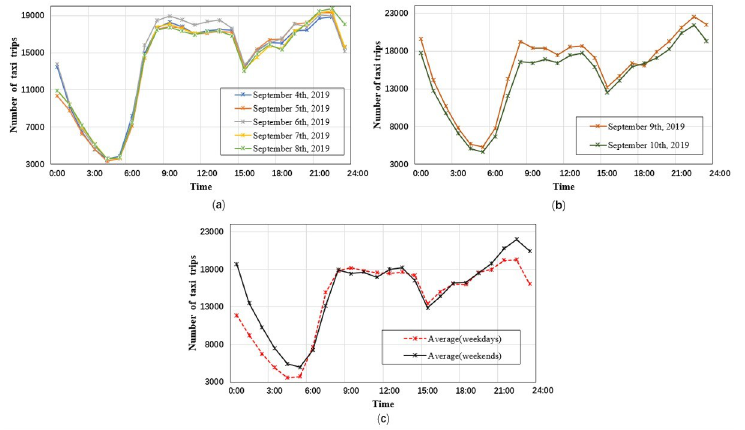
Fig 9. Taxi demand distribution in the main urban area of Xi’an. (a) Taxi demand average hourly from Monday to Friday; (b) taxi demand average hourly from Saturday to Sunday; (c) taxi demand per hour and per day.